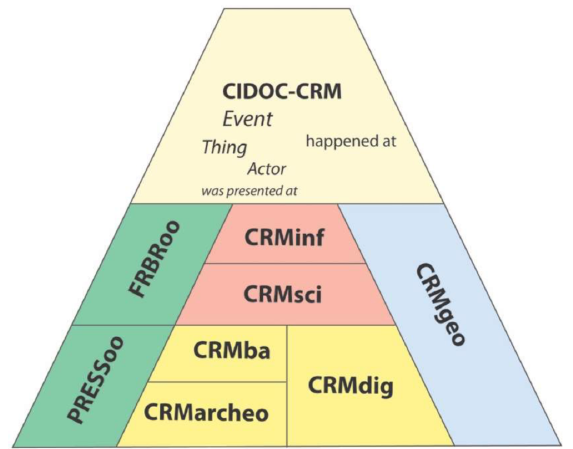
Figure 13 : Presentation of the